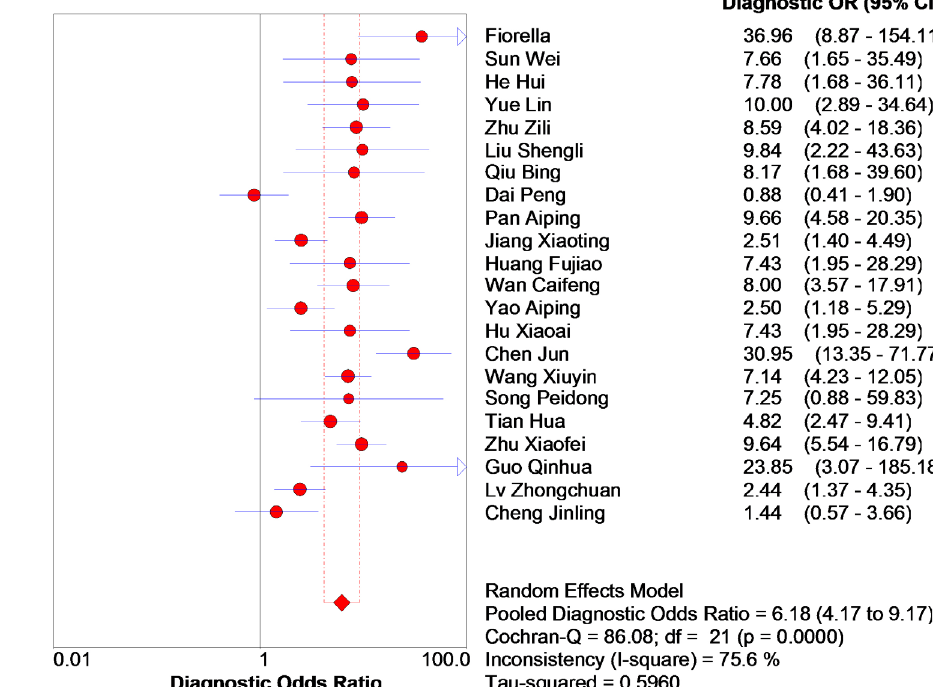
Figure 5: Combined positive likelihoodratio(Positive LR) for serum CA72-4 in the diagnosis of colorectal